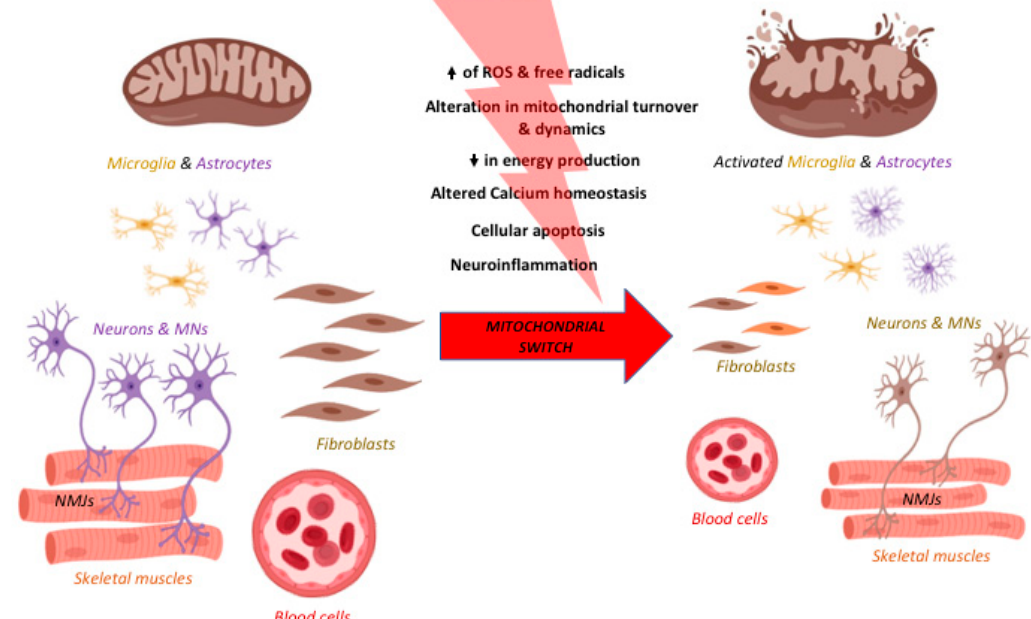
Figure 2. The process of neurodegeneration in the central nervous system (CNS), in the periphery and across diseases. Neurodegeneration is a progressive process taking place not only in the CNS but also in the periphery. After the accumulation of damage at the cellular and, in particular, mitochondrial level, the switch from physiology to pathology is fast and rarely reversible and it is occurring in many cell types. Indeed, it occurs in the CNS but also in the periphery, in particular the neuromuscular junction (NMJ), the skeletal muscles, blood cells, and fibroblasts. Moreover, the major pathways involved are linked to ROS and free radical formation, alterations in ATP formation, calcium homeostasis, apoptosis, mitochondrial turnover and dynamics, and neuroinflammation in terms of microglia and astrocytes activation. These pathways are a ff ected in all the neurodegenerative diseases discussed in this review. Increase of ROS is represented by the black arrow pointing up and reduction in energy production by the black arrow pointing down. Created with BioRender